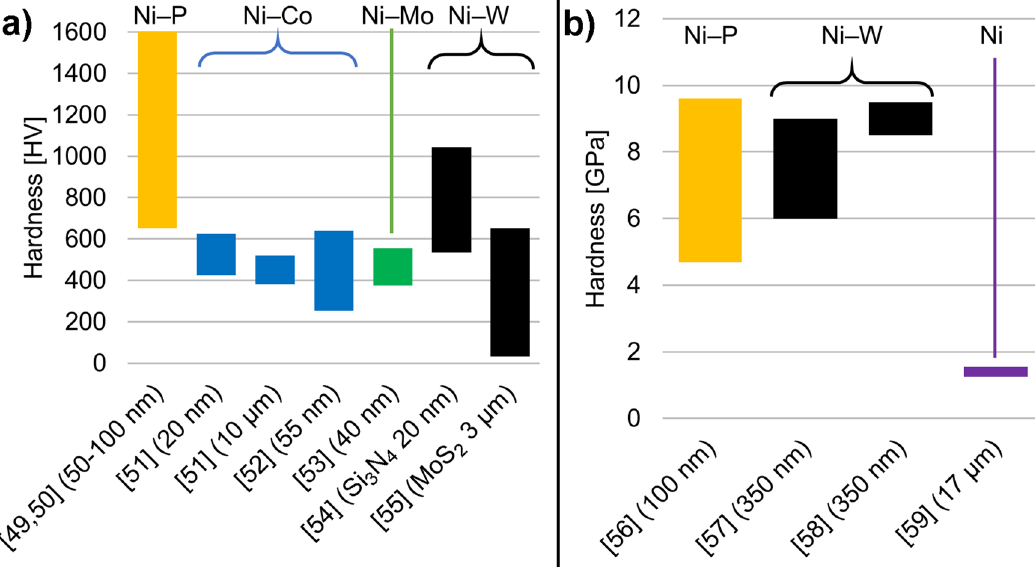
Figure 2. The hardness of composites with various nickel alloys as a matrix: ( a ) results of Vickers micro-hardness tests, ( b ) results of instrumented Berkovich nanoindentation with an exception for Jenczyk’s work, where instrumented Vickers microindentation was carried out.